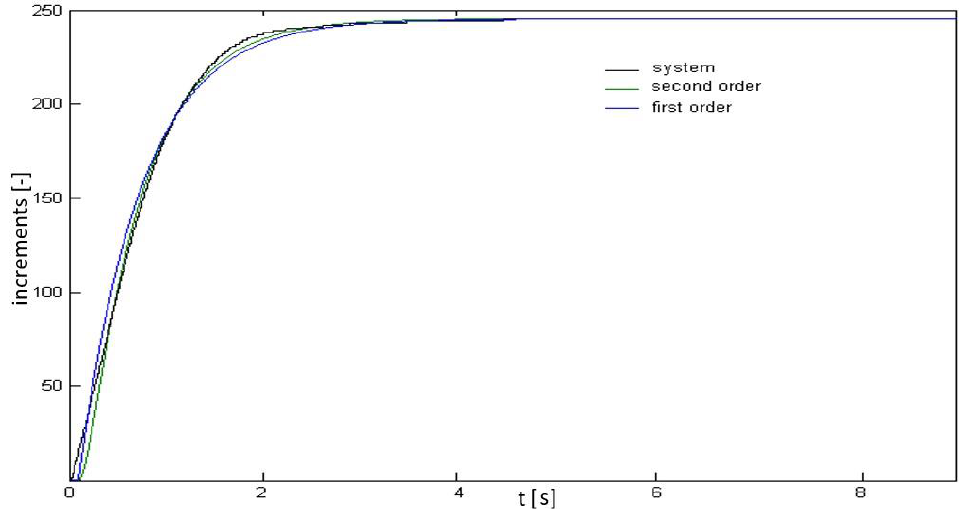
Figure 9. Responses of the linear model of the first and second orders after the identification .